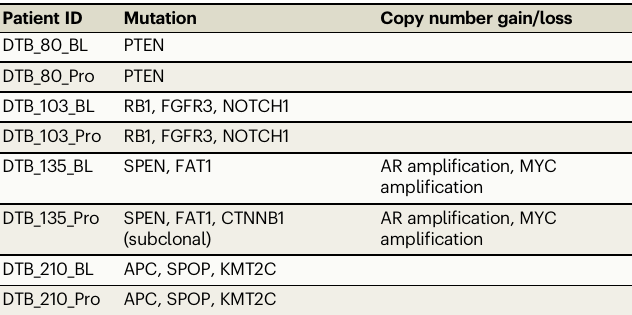
Table 1 | DNA sequencing of matched samples from con- verters demonstrates conserved alterations Patient ID